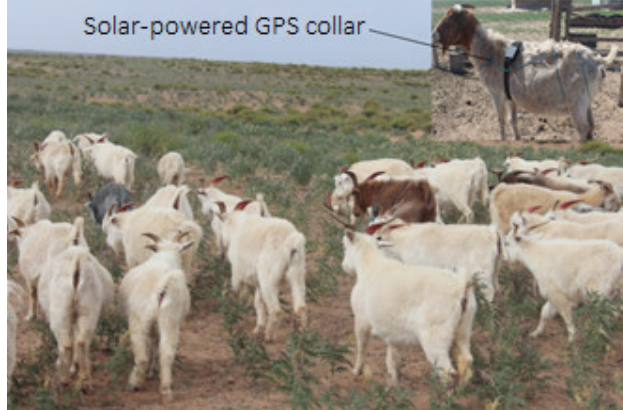
Figure 4. Test sheep with positioning